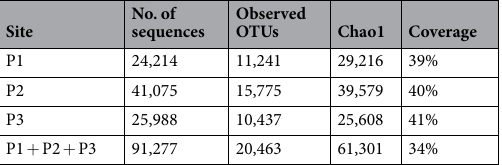
Table 2. Total sequence richness and diversity estimates for combined NRPS and PKS gene sequences with 5% divergence to estimate the overlap among